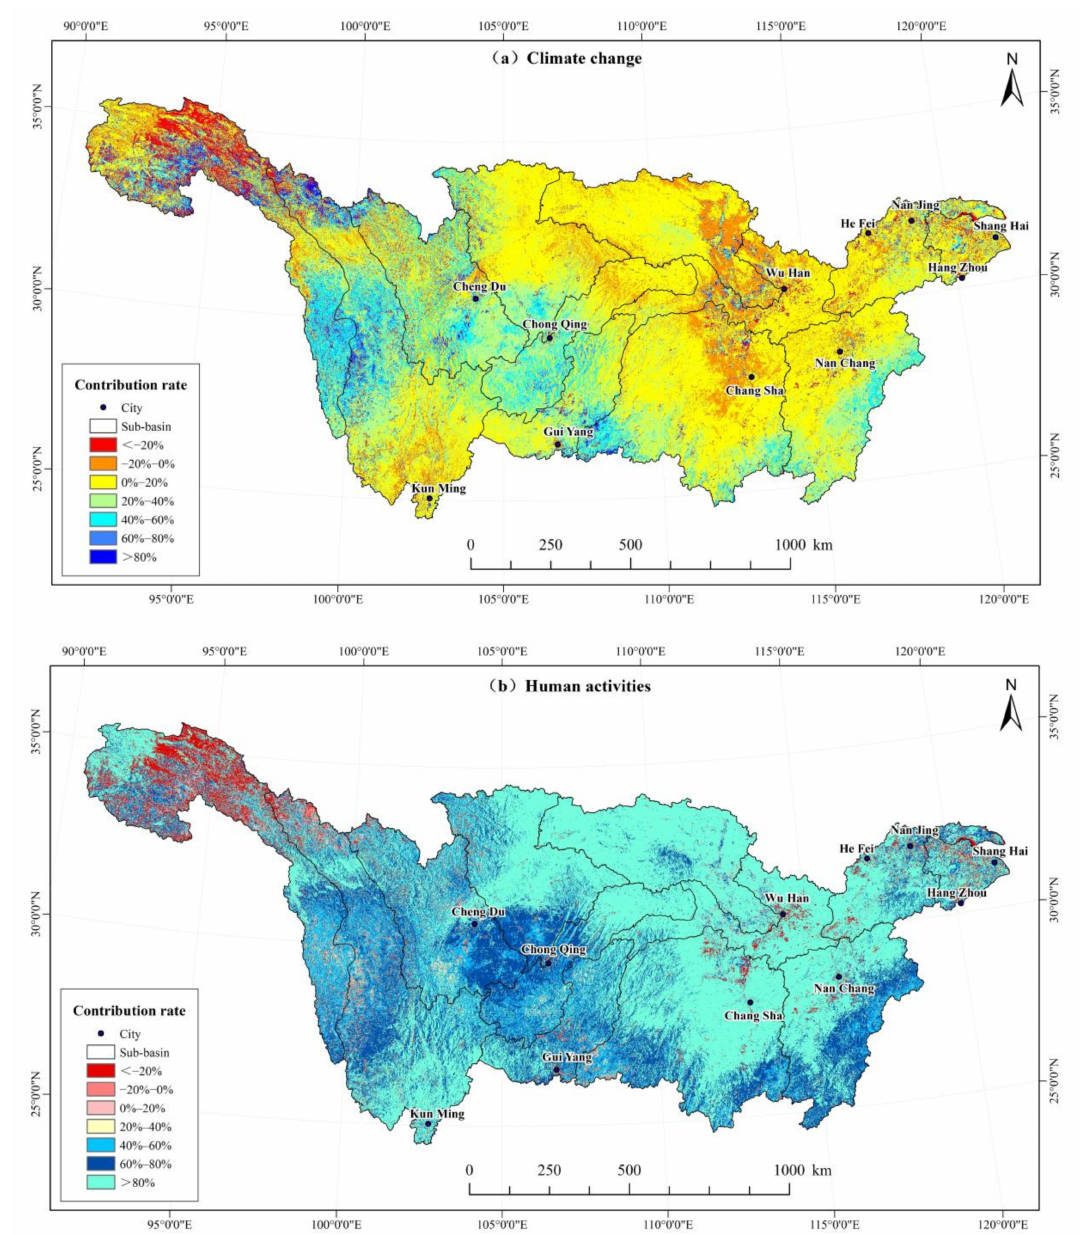
Figure 10. Spatial distribution of contribution rate of climate change and human activities to vegeta- tion cover change in the Yangtze River Basin from 2000 to